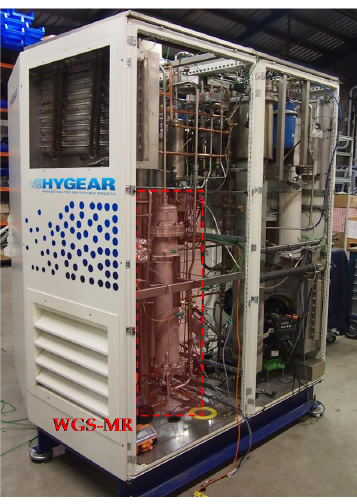
Figure 13. Picture of the prototype reactor for WGS process where the placement of the WGS ‐ MR is highlighted.